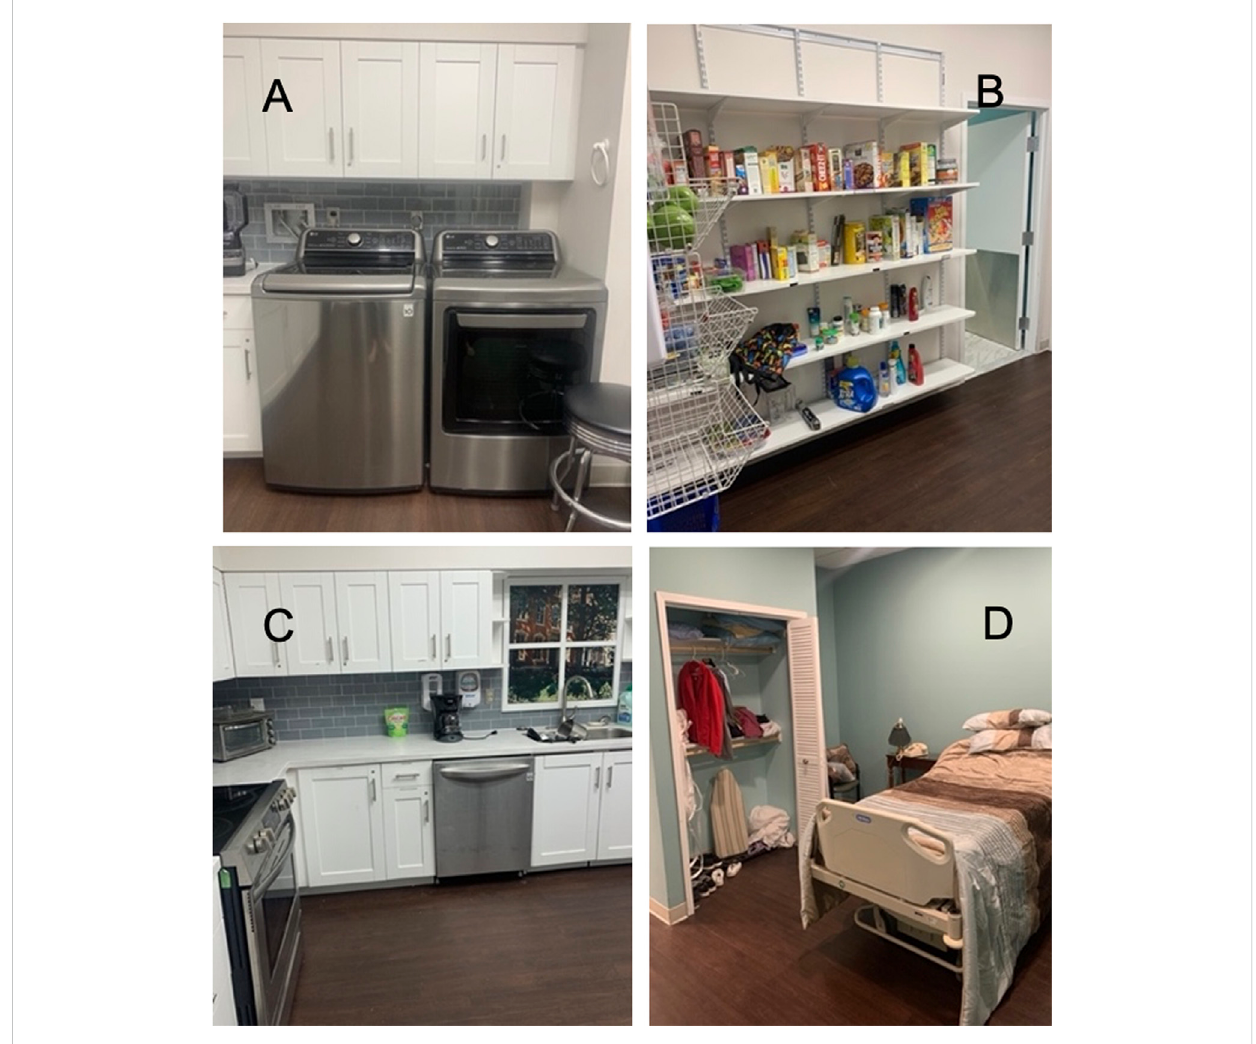
FIGURE 1 Simulated apartment in outpatient rehabilitation. (A) Laundry task. (B) Shopping task. (C) Kitchen task. (D) Bed-making and laundry-folding tasks. Activity scripts are completed using the facilities at MedStar National Rehabilitation Hospital, Washington